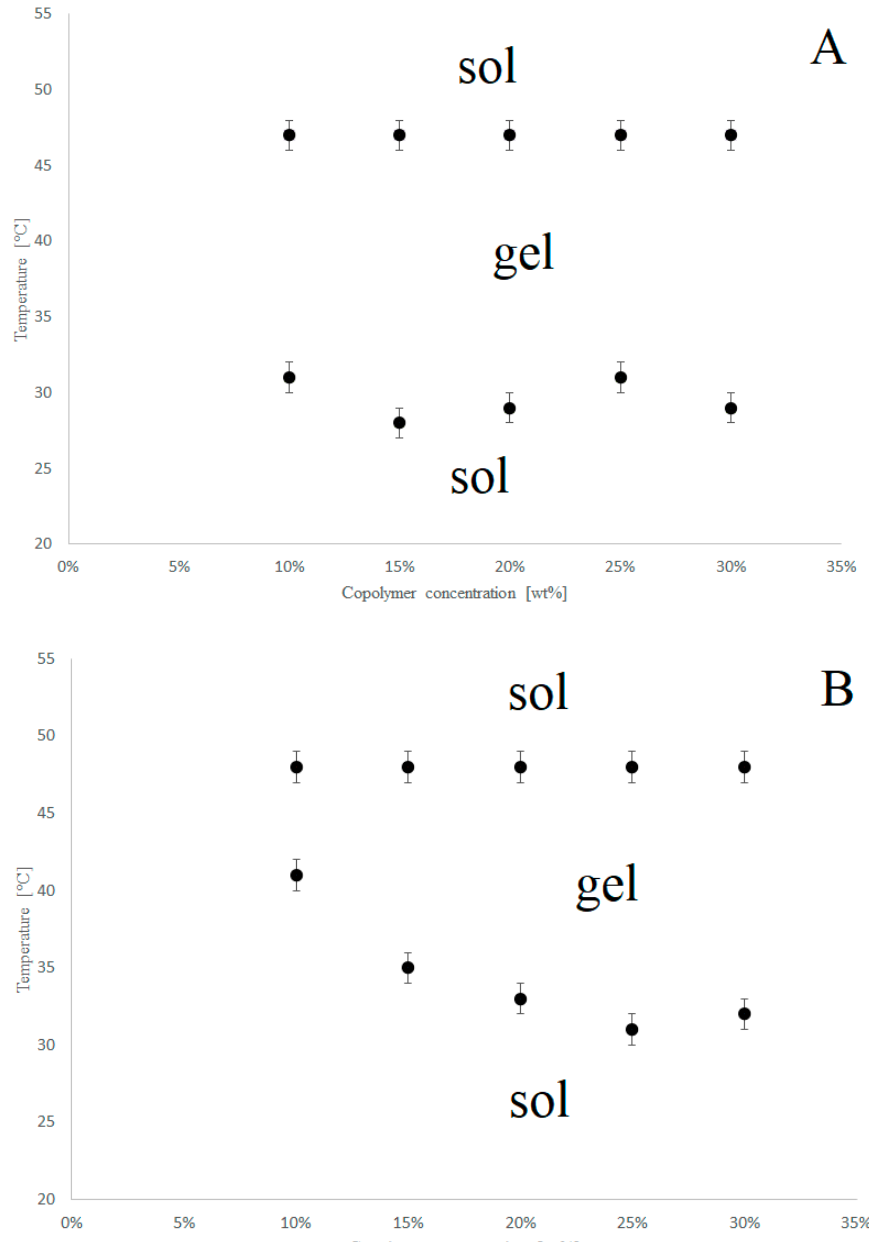
Figure 8. Phase transition diagrams of PCEC-A1.7 ( A ) and PCEC-A2.0 ( B